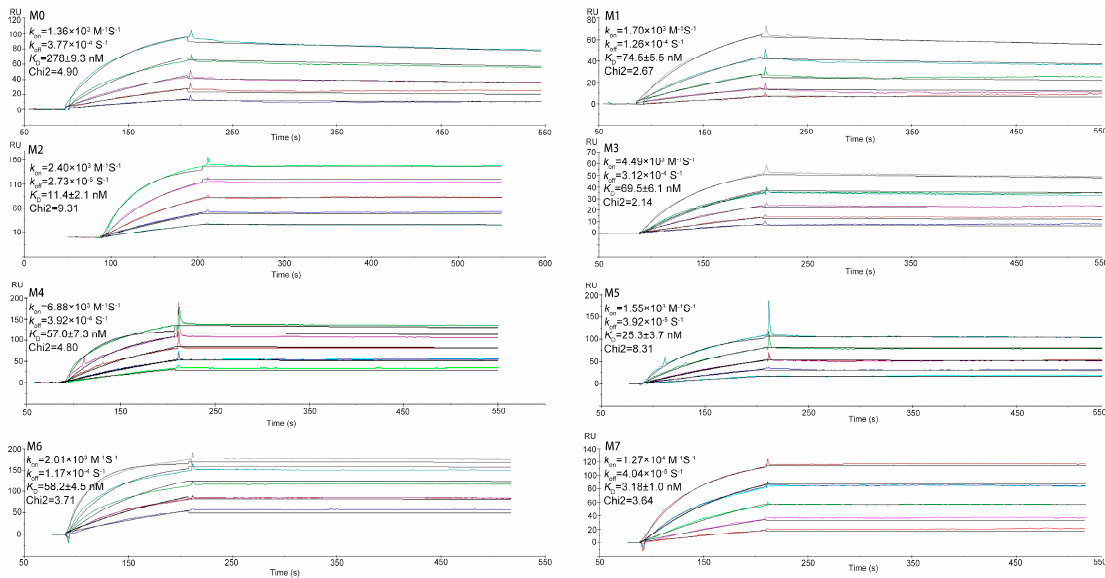
Figure 5. SPR sensorgram binding profiles. Interaction of the parental VHH M0 and mutants M1-M7 with immobilized CD47 ext . The color lines represent the global fits of the raw data (black lines) to a 1:1 bimolecular model. Mean values are shown along with the VHH concentration range used in each experiment.